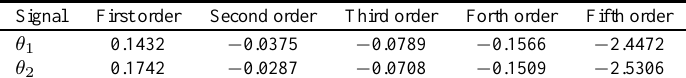
Table 3 Lyapunov exponents of the simulated chaos